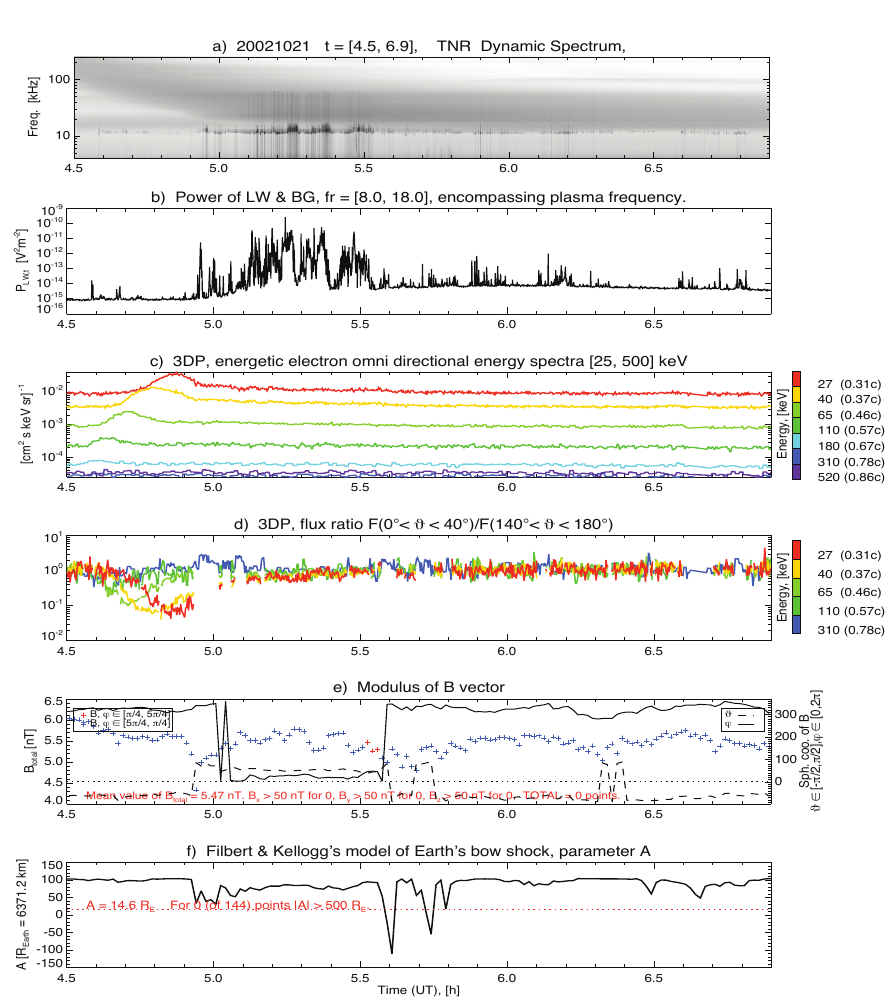
Fig. 1. WIND observations on 2002 October 21 (Bougeret et al. 1995): (a) dynamical spectra, only TNR receiver observations (4{256 kHz), (b) power spectral density inte- grated over narrow frequency band (8{40 kHz) around the plasma frequency ( (cid:24) 12 kHz), (c) Omni directional spectrum of energetic electron (cid:13)uxes, 3DP experiment. The energies are indicated on the right-hand side of the panel (the units on the left-hand side are cm 2 , s, keV, sr − 1 ), (d) Energetic electron (cid:13)ux ratio F(0 ◦ < ϑ < 40 ◦ ) / F(140 ◦ < ϑ < 180 ◦ ), (e) magnetic (cid:12)eld intensity. Plus (+) symbols indicate the direction of magnetic (cid:12)eld vector from the Sun (light gray) or from the Earth (dark gray). Solid and dashed lines indicate two spherical coordinates ( ϑ, φ ), respectively, (f) Parameter A of the Filbert & Kellogg (1979) model of the Earth’s bow shock, i.e., the position of the nose-cone of paraboloid along x-axis in the GSE coordinate system. Its tangent (solar magnetic (cid:12)eld line) goes through the WIND spacecraft. The dotted line indicates the distance along x-axis, from the Earth to the nose-cone of the Earth’s bow shock in steady state. If A is greather than 14.6 Earth’s radii, it means that the WIND spacecraft is out of the Earth’s bow